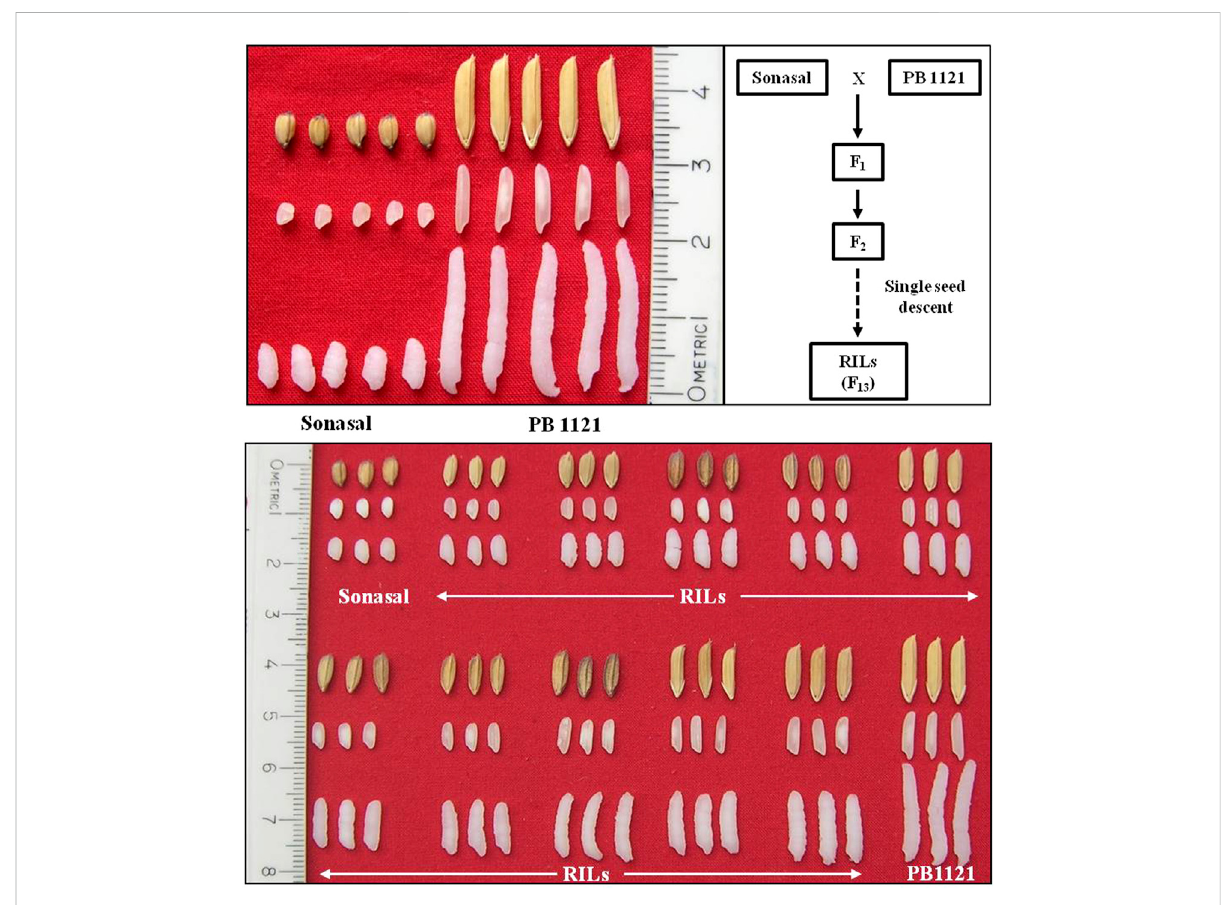
FIGURE 1 Variation for grain dimension traits between parental lines, Sonasal, and PB1121; and RIL